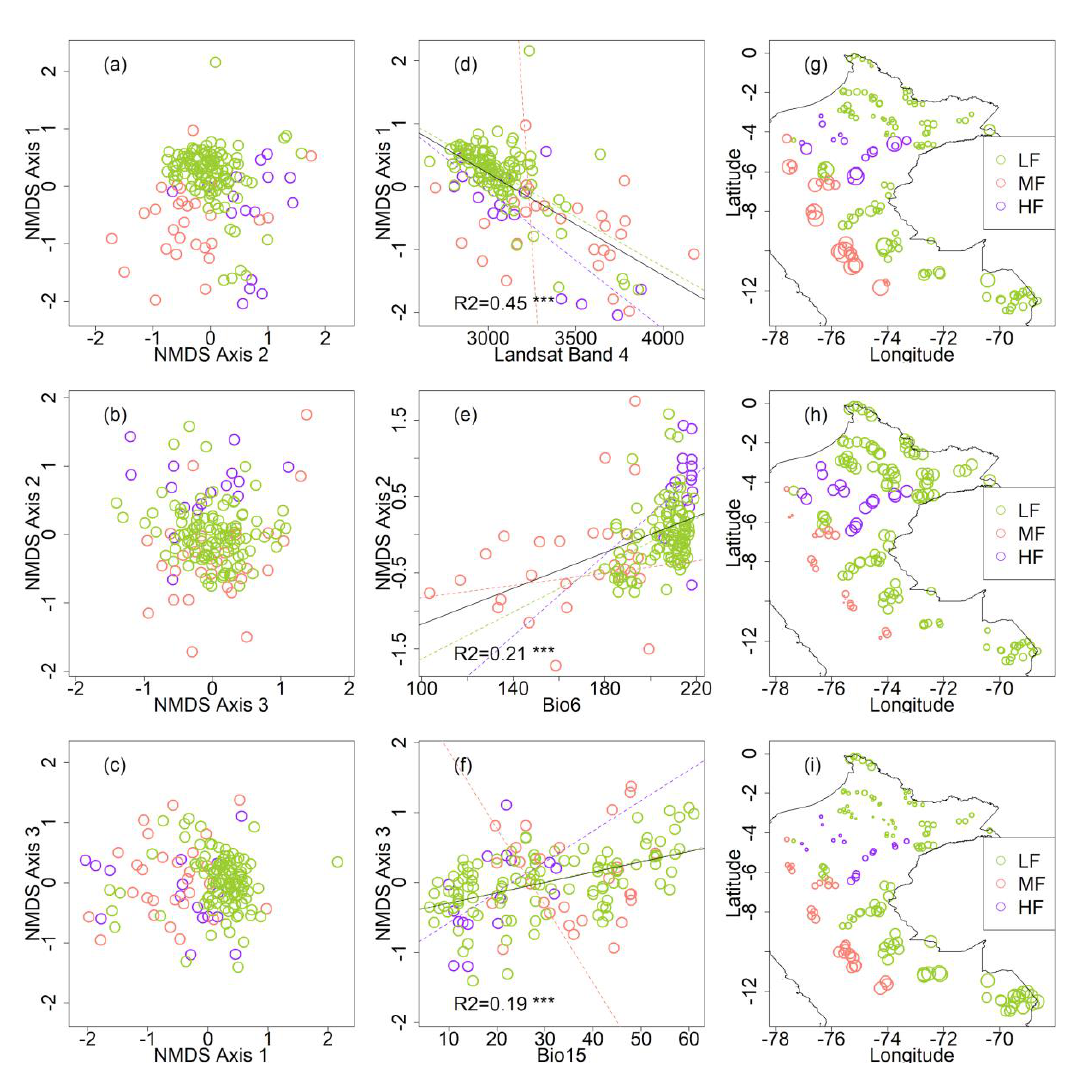
Figure 2. Floristic patterns across Peruvian Amazonia. ( a – c ) Non-metric multidimensional scaling (NMDS) ordination based on floristic dissimilarities between 157 plots (presence-absence data of trees, extended Sørensen dissimilarity). The three NMDS axes together capture 76% of the variation in the original compositional dissimilarity matrix with a stress of 0.19. ( d – f ). Relationship between each floristic NMDS axis and the variable with the strongest correlation with that axis (Bio6 = minimum temperature of the coldest month, Bio15 = precipitation seasonality). Regression lines were calculated for all data together (continuous line) or after subsetting the plots by ecozone (dashed lines). ( g – i ) map of the 157 tree inventory plots indicating the value of the corresponding best predictor (x axis from d, e, and f, respectively). In all panels, colors indicate the different ecozones: green for lowland forests (HF), orange for montane forests (MF), and purple for hydromorphic forests (HF). The full names and abbreviations of all variables are listed in Table S1. Table 1. Relationships between the genus-level floristic composition of trees and environmental and Landsat variables. (1) Correlation values of partial Mantel tests between the distance matrices of the floristic composition and each of the Landsat and environmental variables separately, partialling out the correlation with the geographical distance. Statistical significance of each correlation coefficient was assessed with a Monte Carlo permutation test using 999 permutations. (2) Pearson correlation coefficients of simple linear correlation between each of the floristic ordination axes (NMDS 1 – 3) and each Landsat and environmental variable. ∗∗∗ P < 0.001, ∗∗ P < 0.01, ∗ P < 0.05. Bands 1 – 7 refer to the Landsat bands, Bio1-19 refer to each of the bioclimatic variables (http://chelsa-climate.org/bioclim/),